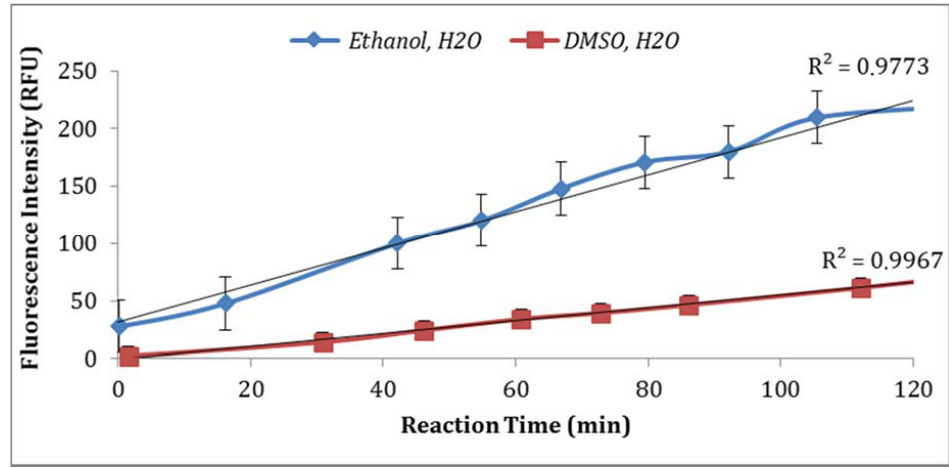
Figure 4. Impact of different solvents for dissolving MUG on assay sensitivity (fluorescence intensity).